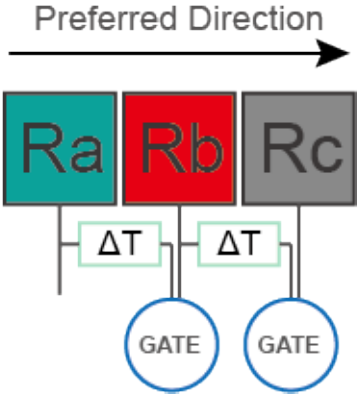
Figure 1. The mechanism of Barlow’s excitory scheme.